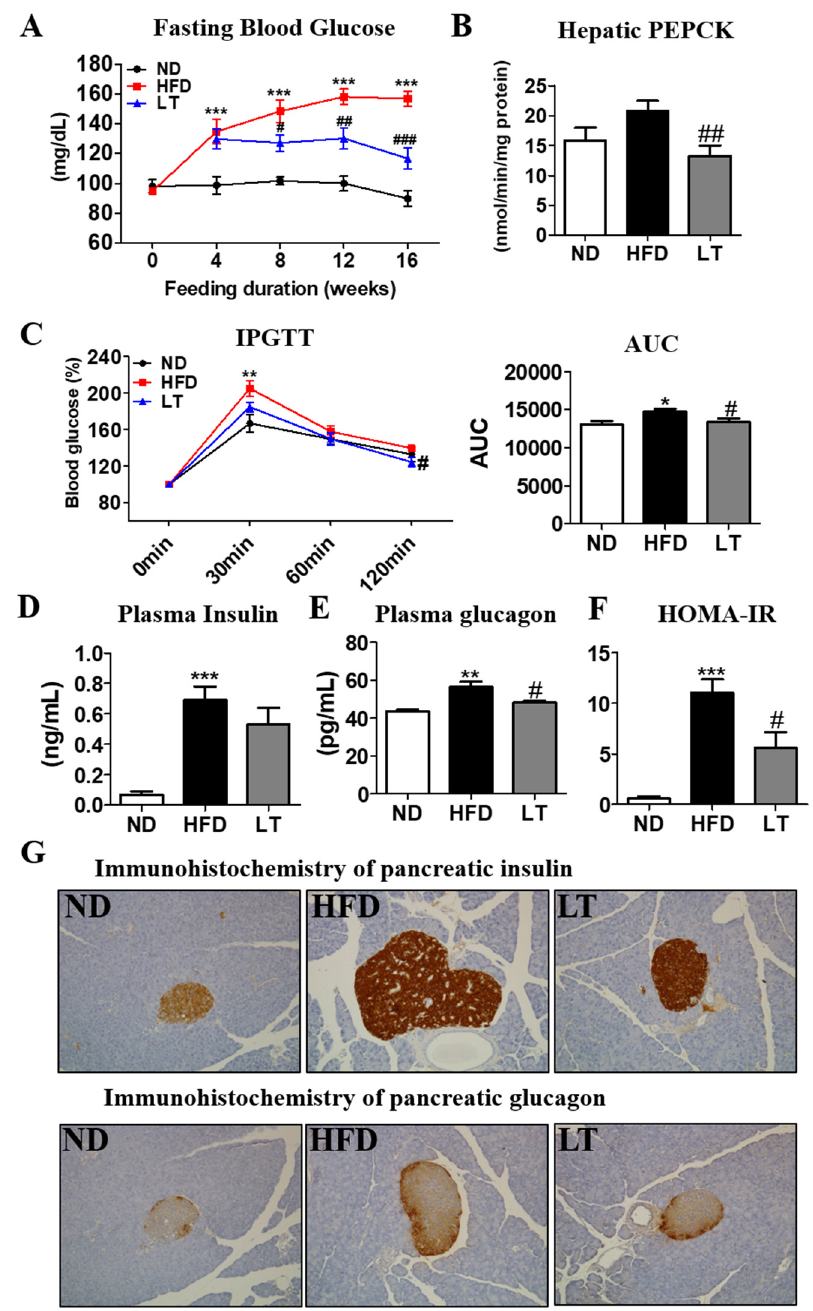
Figure 4. Effect of LT water extract supplement in diet-induced obesity on energy expenditure and fasting blood glucose ( A ), hepatic PEPCK ( B ), IPGTT and AUC ( C ), plasma insulin ( D ), plasma glucagon ( E ), HOMA-IR ( F ), pancreatic immunohistochemistry analysis (200 × magnification) ( G ). Data are the mean ± SE. Significant differences between HFD versus ND are indicated: * p < 0.05, ** p < 0.01, *** p < 0.001. Significant differences between HFD versus LT are indicated: # p < 0.05, ## p < 0.01, ### p < 0.001. ND, normal diet (AIN-93G); HFD, high-fat diet (60% kcal from fat); LT, HFD + Lycopus lucidus Turcz water extract (1.5%, w / w ); PEPCK, phosphoenolpyruvate carboxykinase; IPGTT, intraperitoneal glucose tolerance test; AUC, area under the curve; HOMA-IR, homeostasis model assessment of insulin resistance; PEPCK, phosphoenolpyruvate